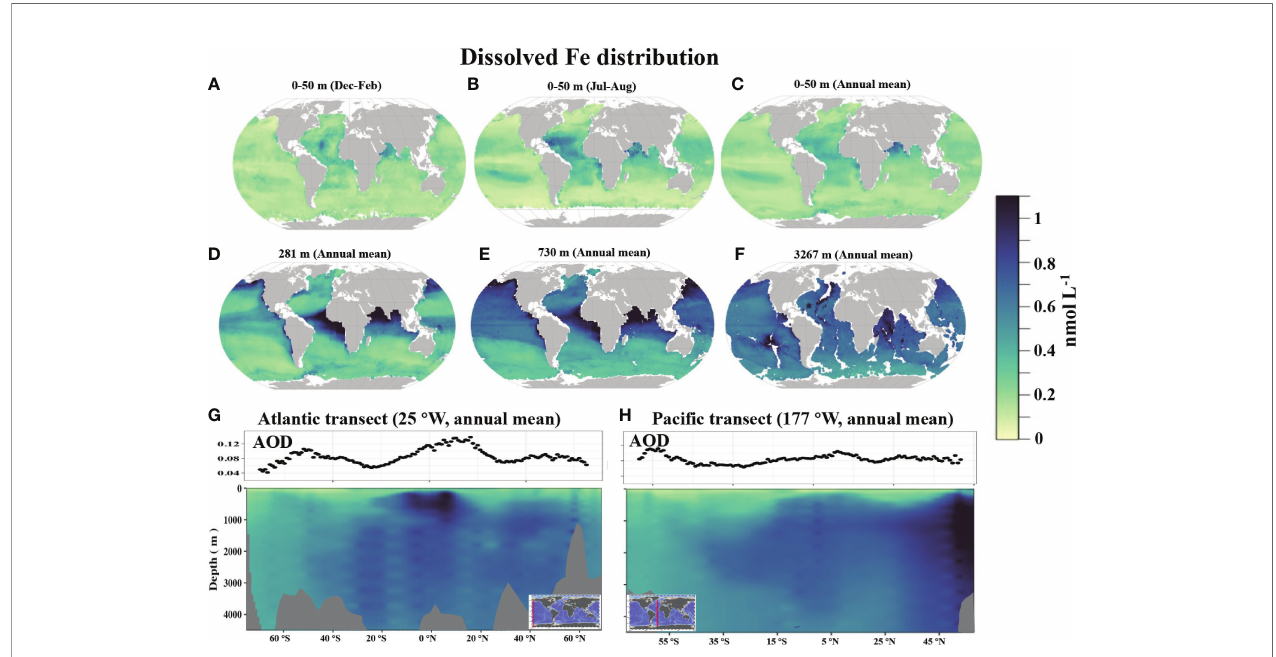
FIGURE 5 | The global modeled dissolved Fe using the random forest approach. (A – F) show global maps of modeled dissolved Fe at various depth horizons; (G, H) display the corresponding dissolved Fe transects across the Atlantic and Paci fi c.